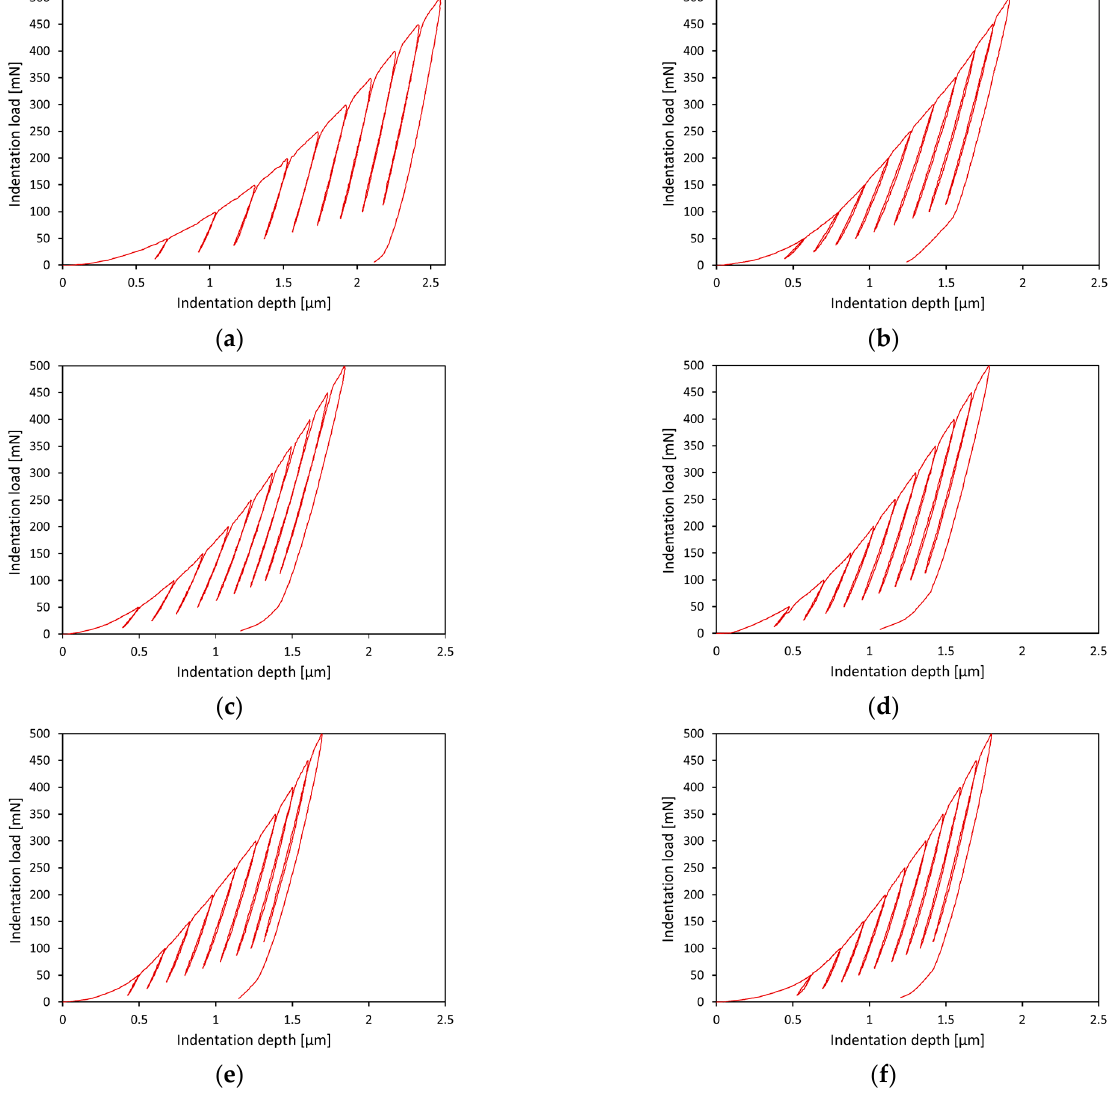
Figure 2. Representative indentation load-depth curves for the Ti-6Al-7Nb alloy in the initial state ( a ) and after oxidation at 600 °C ( b ), 650 °C ( c ), 700 °C ( d ), 750 °C ( e ), and 800 °C ( f ) over a period of 72 h.